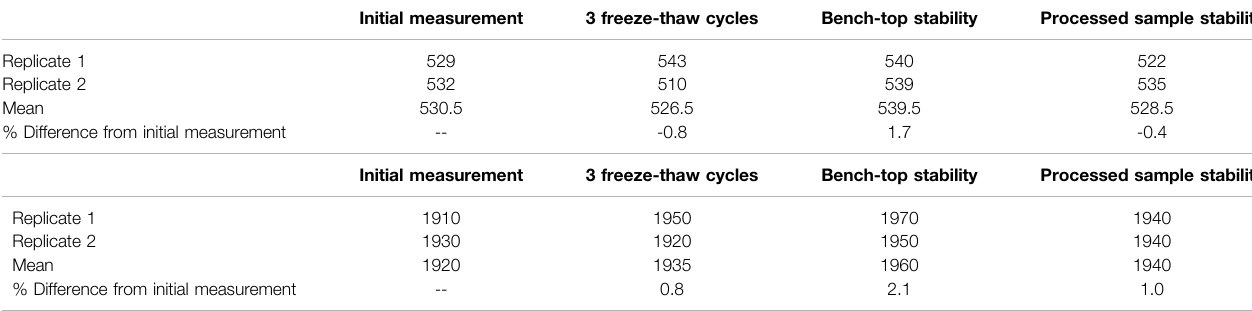
TABLE 3 | 8-isoprostane stability in BAL fl uid